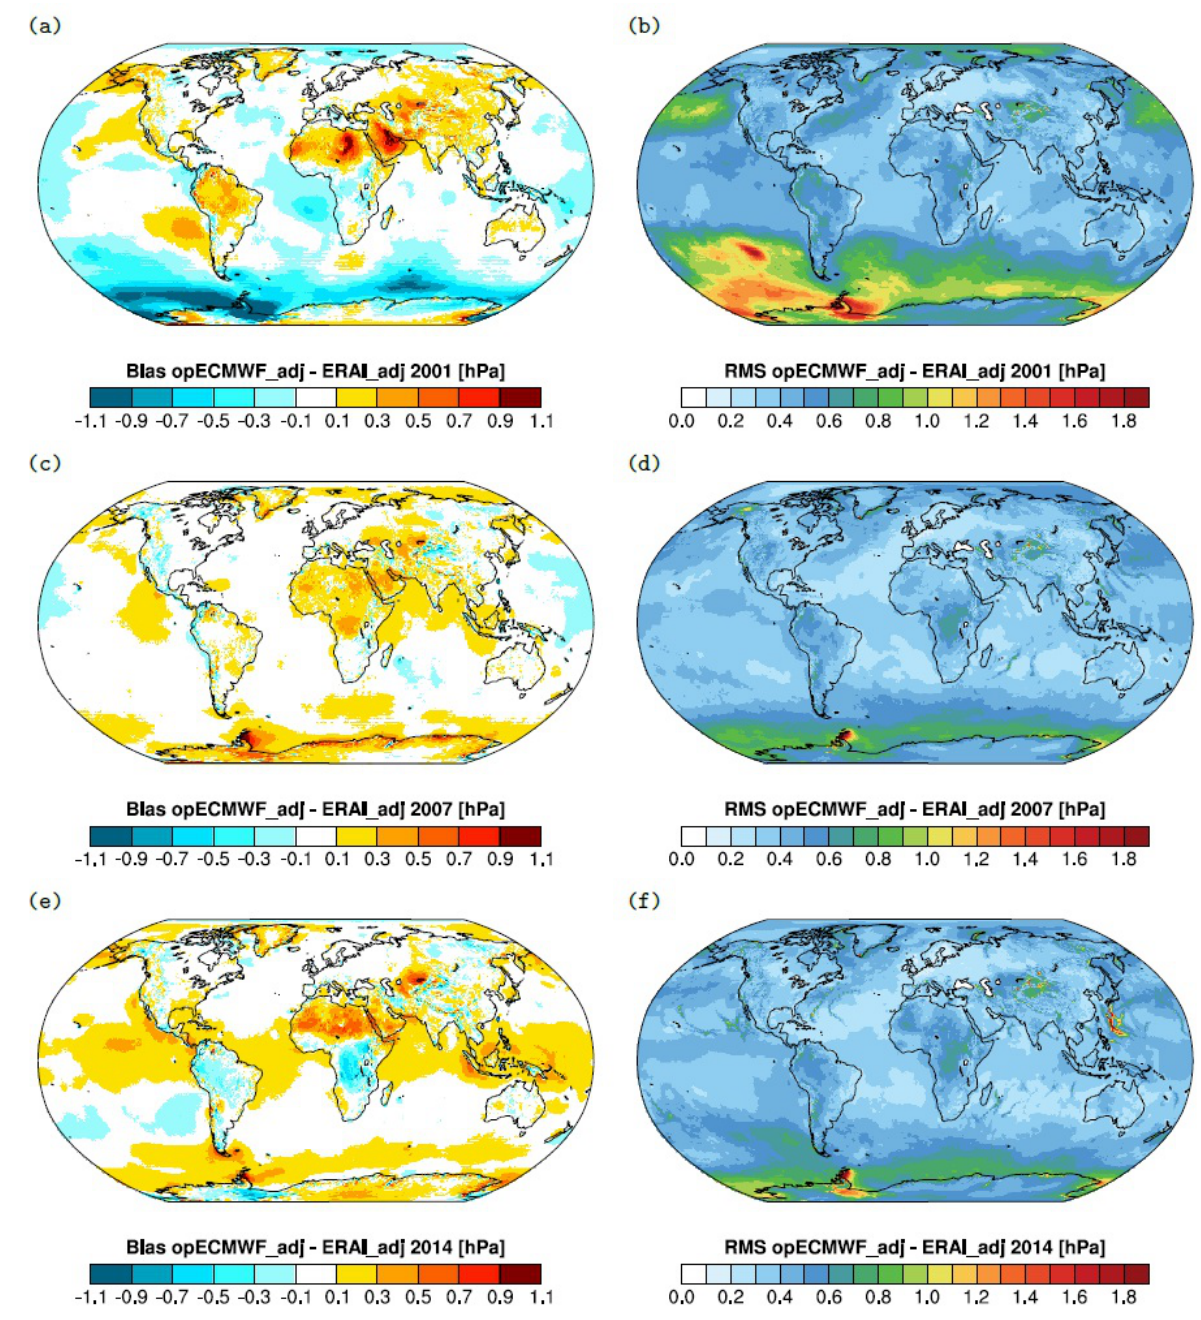
Figure 2: Relative biases (left column) as well as RMS of zero-centered residuals (right column) of surface pressure from the operational ECMWF analyses and ERA-Interim reanalyses both reduced to the same reference orography at a spatial resolution of 0.5 ∘ that are calcu- lated individually for the years 2001 (top row), 2007 (middle row), and 2014 (bottom